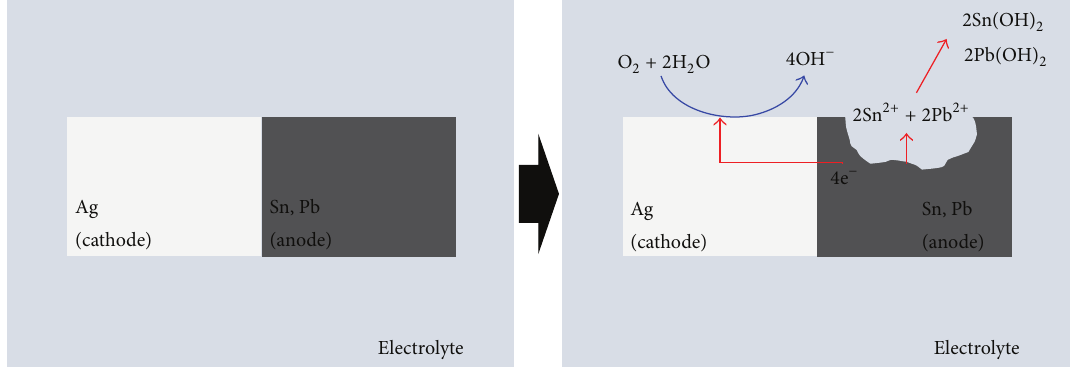
Figure 2: Corrosion mechanism at the interface between SnPb solder and Ag paste.